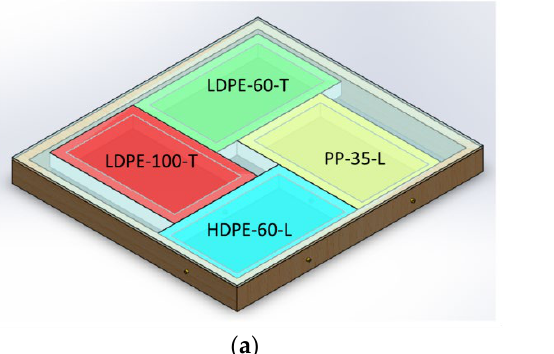
Figure 5. Experimental set up scheme. ( a ) Transparent films distribution with glass. ( b ) Transparent film distribution without glass.